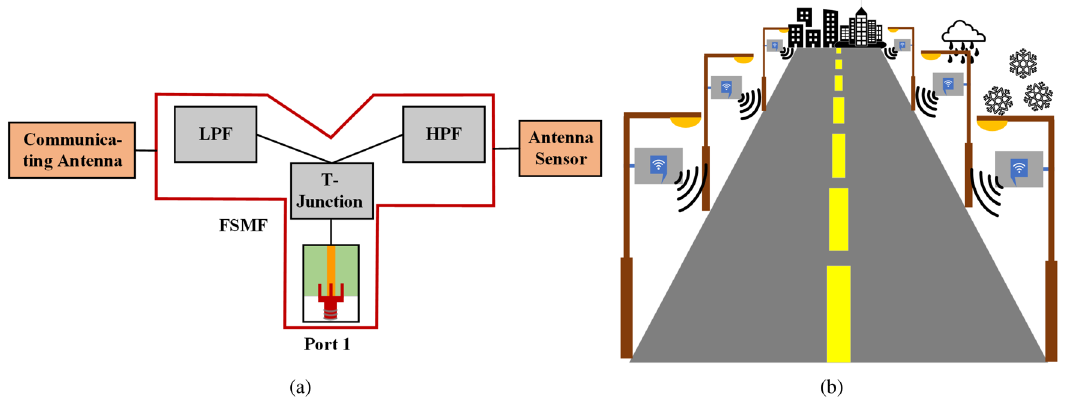
Figure 2. ( a ) The design overview of the proposed system. ( b ) Wi-Fi access points around the roadway